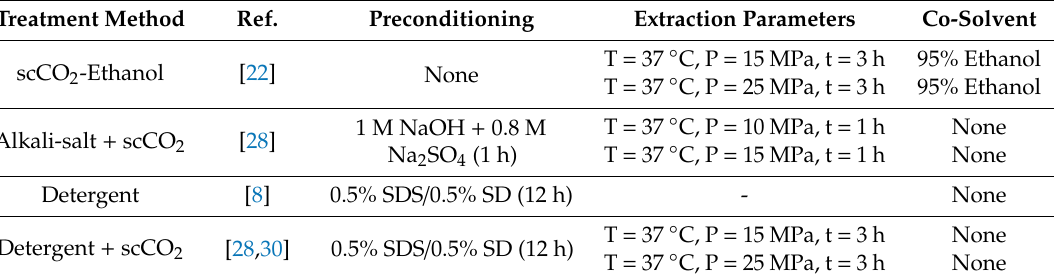
Table 2. Protocols for the decellularization of ovine aortic